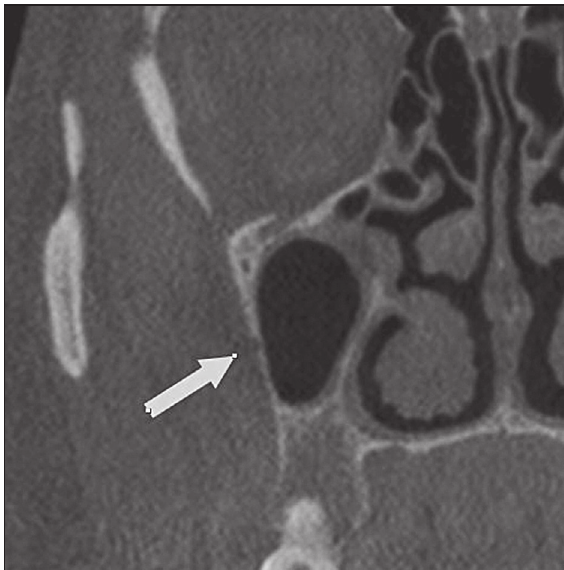
Figure 4 - Coronal view of the maxillary sinus reveals the artery (arrow), which is on the outer cortex of the lateral sinus